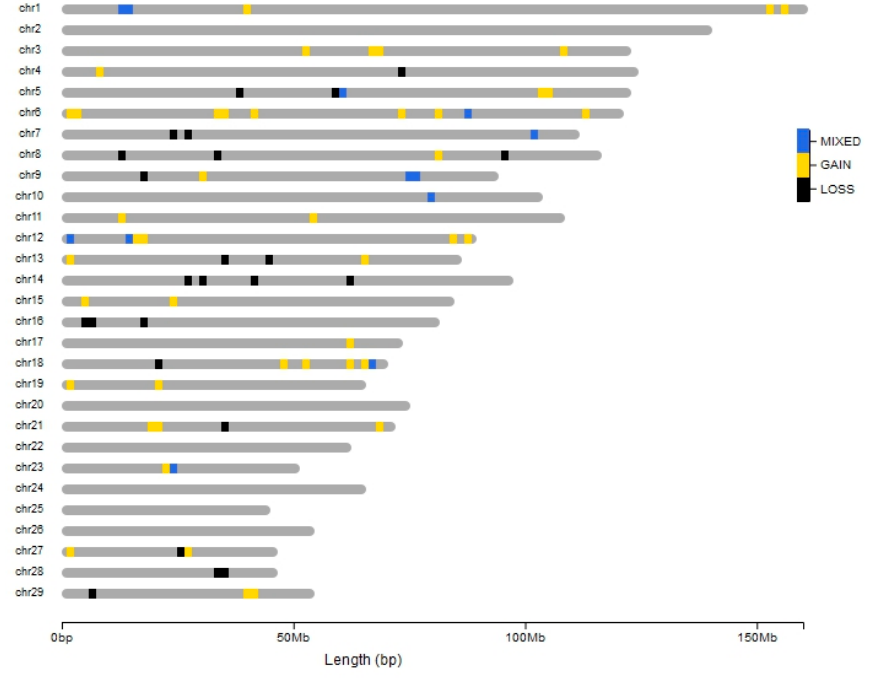
Figure 2. Ideogram of the distribution of the copy-number variation regions (CNVRs) in Sicilian goat breeds. Blue, yellow, and black colours represent mixed, gain, and loss events, respectively.